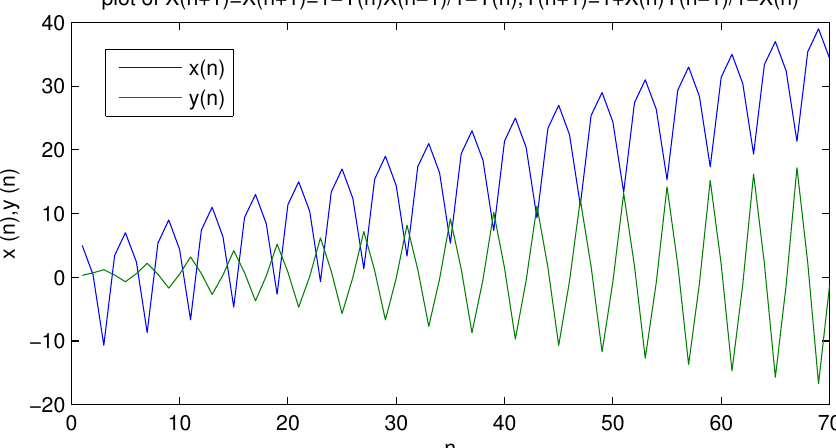
Figure 2. Shows the behavior for System (2) with the initial values x − 1 = 5, x 0 = 0.4, y − 1 = 0.3 and y 0 = 0.7.